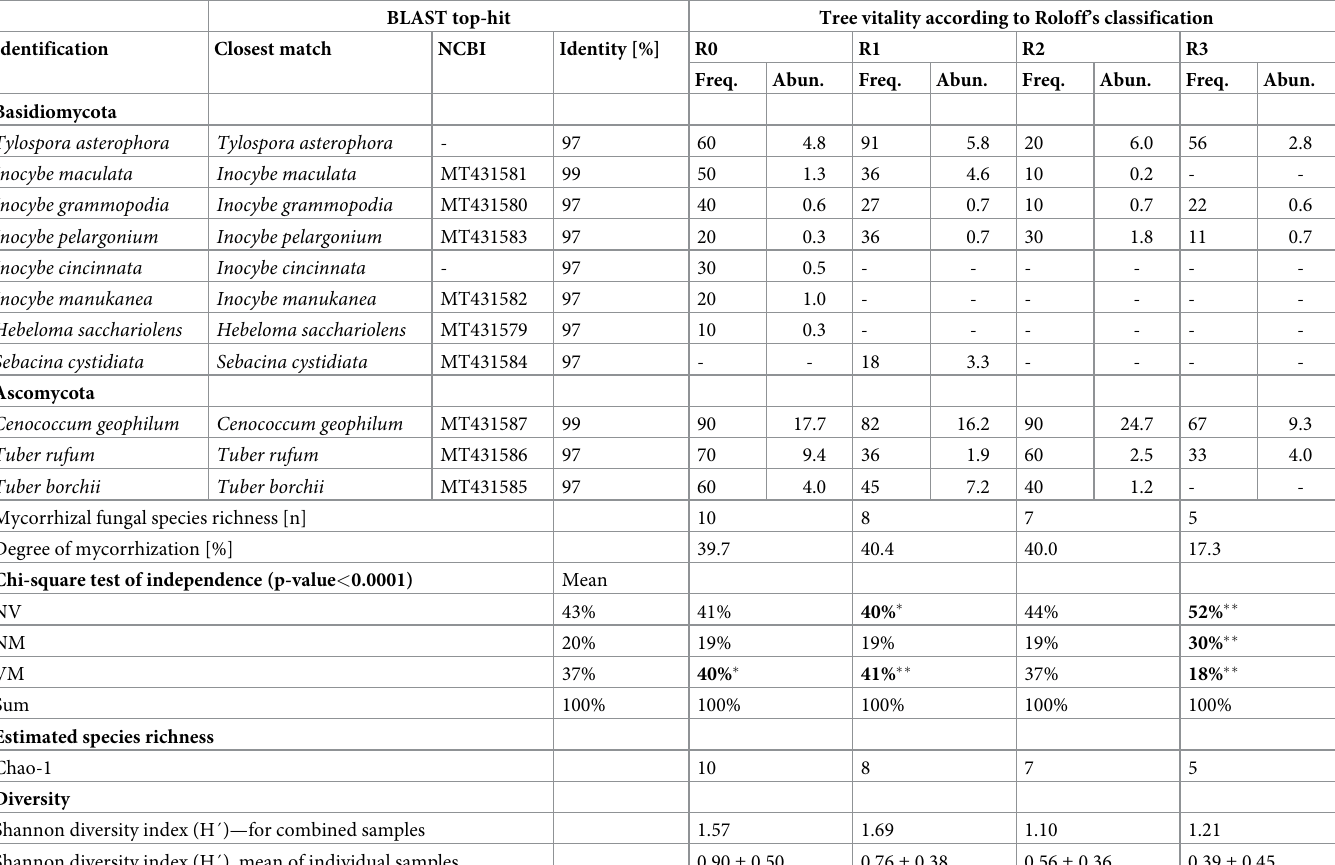
Table 1. Estimated species richness, diversity and occurrence of fungal taxa associated with the roots of linden trees.